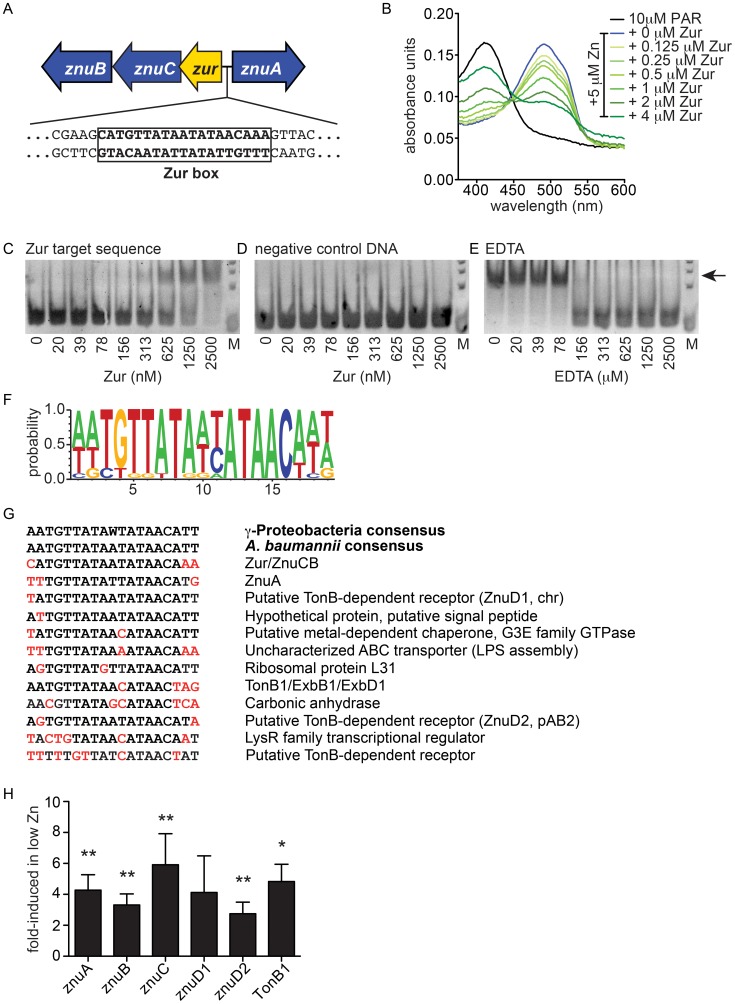
Genetic characterization of a putative Zn uptake system in A. baumannii.
(A) Schematic representation of the genomic locus containing znuA and the zurznuCB operon. The sequence corresponding to a putative zur box is shown. (B) PAR assay measuring Zn binding by Zur. Spectral scans of solutions containing 10 µM PAR without Zn (black line), with Zn (blue line) or with Zn and increasing concentrations of Zur (green lines) are shown. (C–D) EMSA assays measuring binding of Zur to Zur target DNA (C) or negative control DNA (D) in the presence of Zn. (E) EMSA assay demonstrating loss of Zur binding to target DNA in the presence of increasing concentrations of EDTA. Arrow indicates mobility of shifted band. (F) Consensus sequence for the A. baumannii Zur box. (G) Predicted Zur-regulated genes and their predicted Zur boxes. (H) Expression analyses of genes predicted to be involved in Zn uptake across the outer (znuD1, znuD2, TonB1) and inner (znuA, znuB, znuC) membranes. Asterisks indicate relative expression that is statistically greater than one, where 1-fold indicates no change in expression in TPEN treated bacteria compared to untreated bacteria. * p<0.05, ** p<0.01 as determined by one sample t test using a reference value of one.